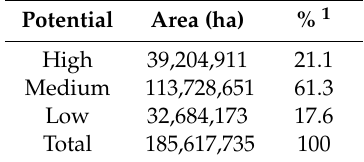
Figure 4. AgroclimaticspatialareasestimatedforJCLcultivationinMexico.Highpotential(greenpolygon), medium potential (yellow polygon) and low potential (red polygon). Table 10. Suitable areas for JCL cultivation in Mexico.